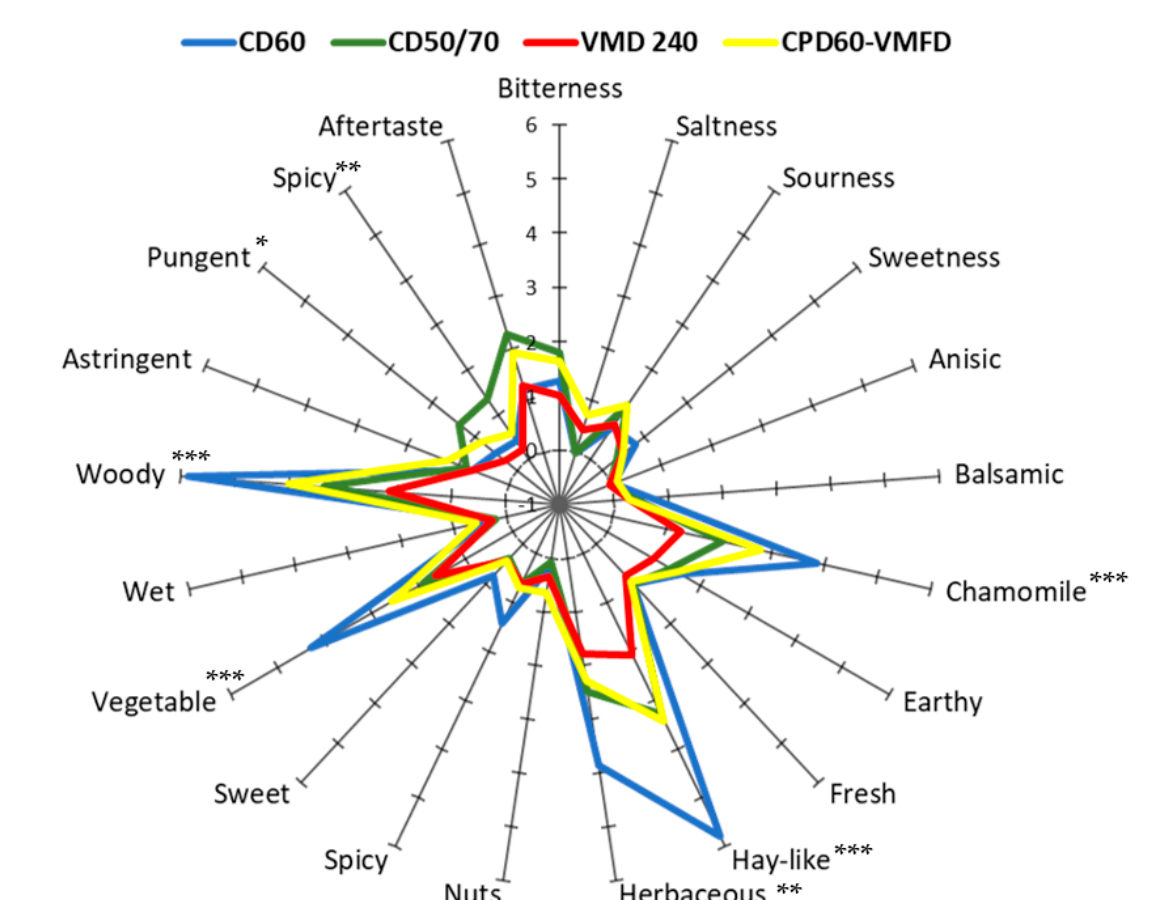
Figure 3. Descriptive sensory results for cilantro samples from each type of drying treatment. The scale used ranged from 0 = no intensity to 10 = extremely strong intensity; *, **, and *** significant at p < 0.05, 0.01, and 0.001, respectively.